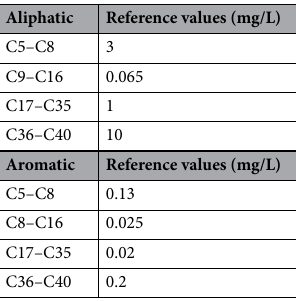
Table 1. Reference standards for petroleum hydrocarbons. TPHCWG,